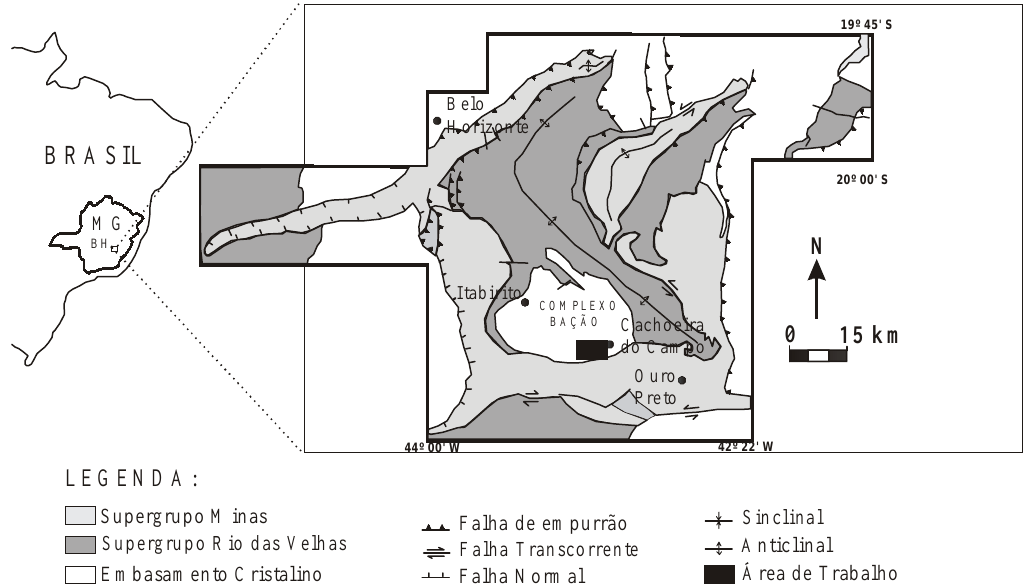
Figura 1. Esboço da Geologia do Quadrilátero Ferrífero com o Complexo Bação e área de trabalho